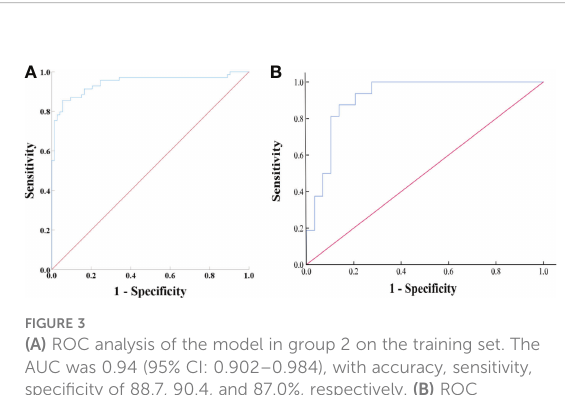
FIGURE 3 (A) ROC analysis of the model in group 2 on the training set. The AUC was 0.94 (95% CI: 0.902 – 0.984), with accuracy, sensitivity, speci fi city of 88.7, 90.4, and 87.0%, respectively. (B) ROC analysis of the model in group 2 on the external validation set. The AUC was 0.91 (95% CI, 0.823 – 0.927) with accuracy, sensitivity, and speci fi city of 82.2, 69.0, and 90.0%, respectively.